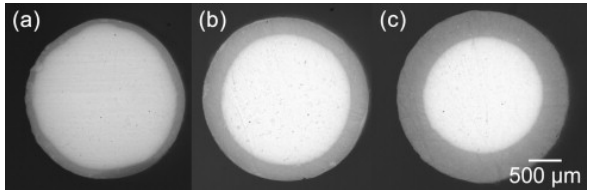
Fig. 22 SEM images of cross-sections of zirconia toughened alumina micro rods prepared using initial alumina thickness of (a) 0.5 mm, (b) 1.0 mm, (c) 1.5 mm. Reproduced with permission from Ref. [135], © Elsevier Ltd.